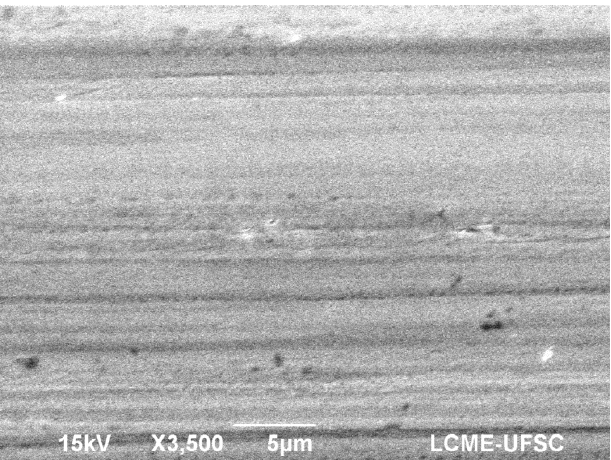
Figure 11. Micrograph (3500X) of the surface of a steel